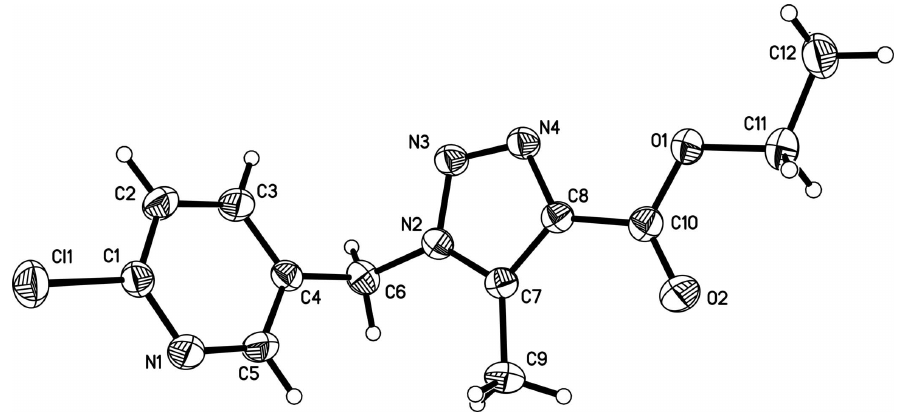
Figure 1 View of the molecular structure of (I), showing the atom labelling schemeand with displacement ellipsoids drawn at the 50% probability level.